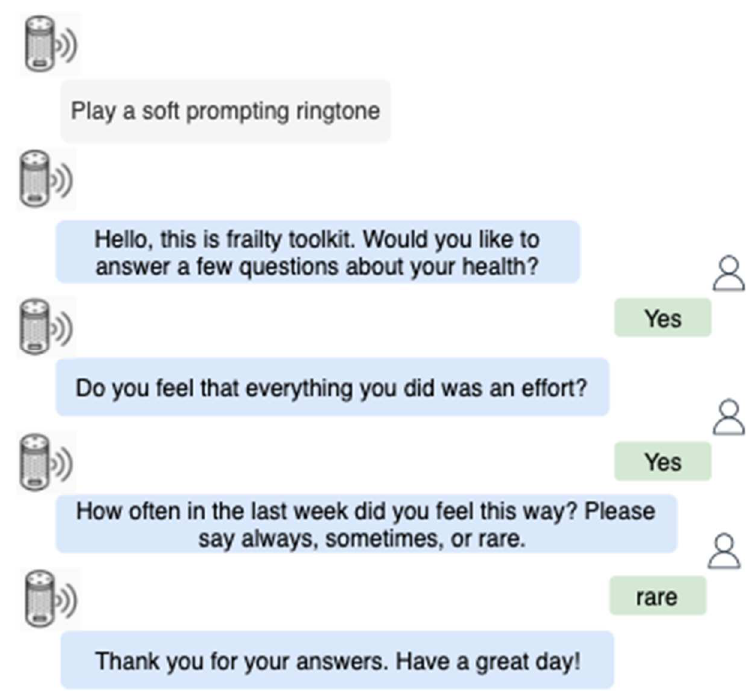
Figure 2. Sample smart speaker conversation.